Question: Summarize what this figure shows in one sentence.
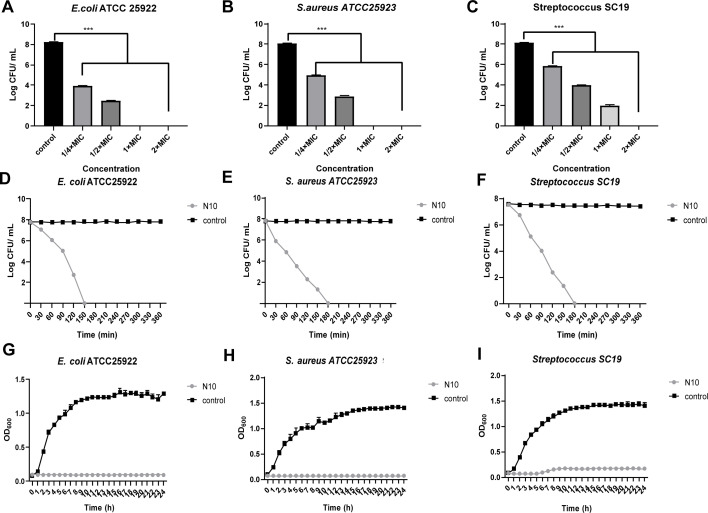
Answer: N10 is a stable antimicrobial peptide with significant antimicrobial effects. ( A–C ) Bactericidal activity of N10 against E. coli ATCC 25922, S. aureus ATCC 25923, and Streptococcus SC19. The bacteria were cultured with peptide N10 at 1/4× MIC, 1/2× MIC, 1× MIC, or 2× MIC, and the untreated group was used as a control. The CFUs of the surviving bacteria were counted. ( D–F ) Time‒kill curves of N10 in E. coli , S. aureus, and Streptococcus . The bacteria were mixed with 1× MIC of N10 and cultured at 37°C, and the CFUs were counted every hour for a series of 12 h. The untreated group was used as a control. ( G–I ) Growth curves of E. coli ATCC 25922, S. aureus ATCC 25923, and Streptococcus SC19 strains treated with N10. The OD 600 of the bacteria treated with 1/2× MIC N10 was continuously measured for 12 h. Student's t -test was applied for statistical analysis. Data are presented as mean ± standard error of the mean, significance levels were defined as P < 0.001 (***).